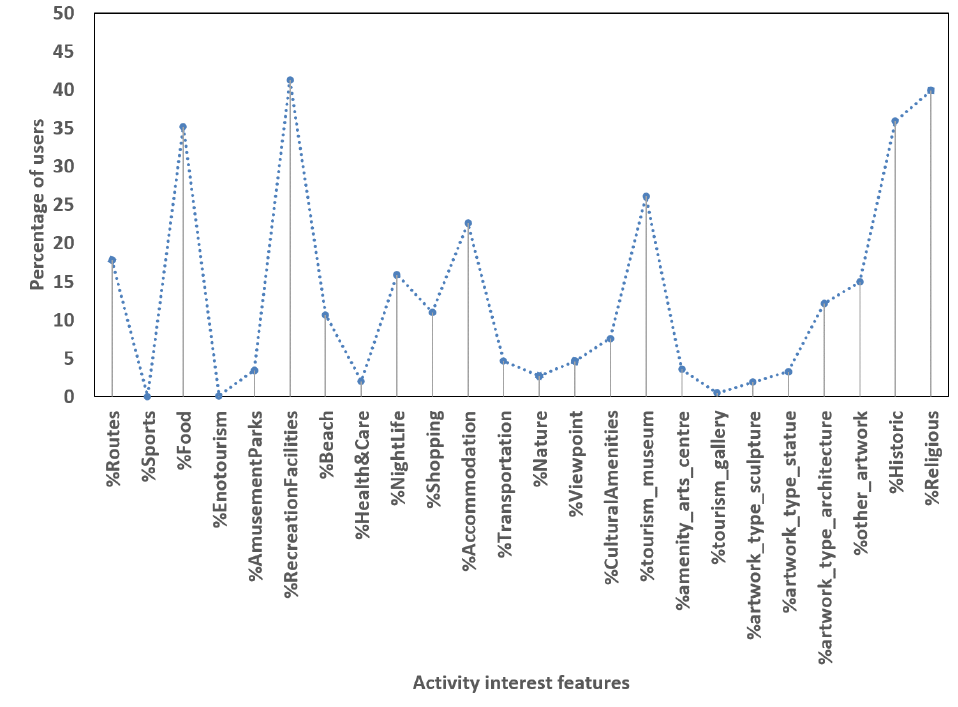
Figure 4. Activity features by percentages of